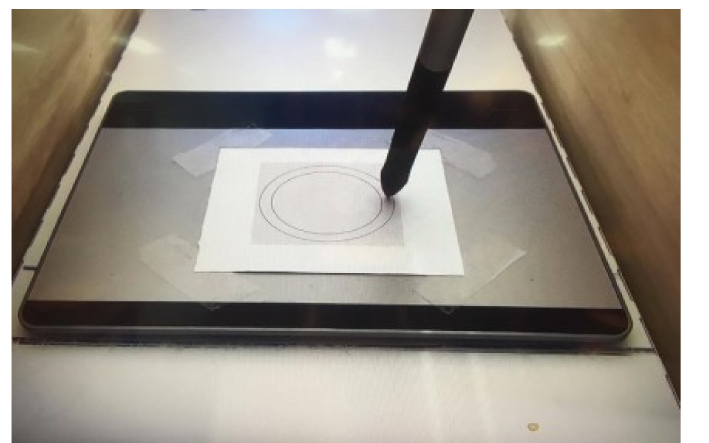
Figure 2. Peg transfer task.